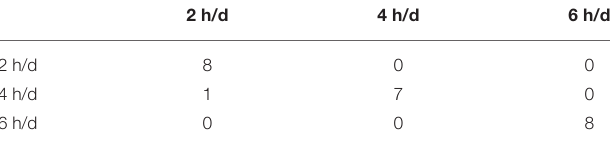
TABLE 2 | Confusion matrix obtained by GA-LDA in tracing the diet of lactating ewe groups submitted to different part-time grazing regimens differing for daily access time (2, 4, and 6